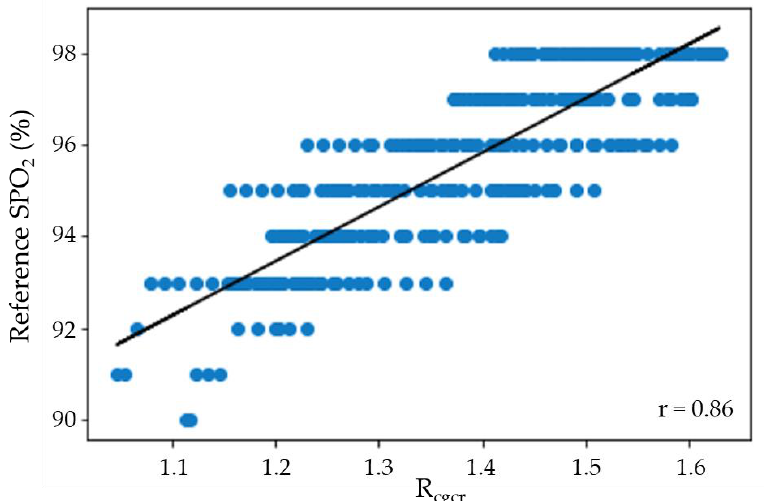
Figure 5. Scatter plot showing the relationship between R cgcr and the reference SPO 2